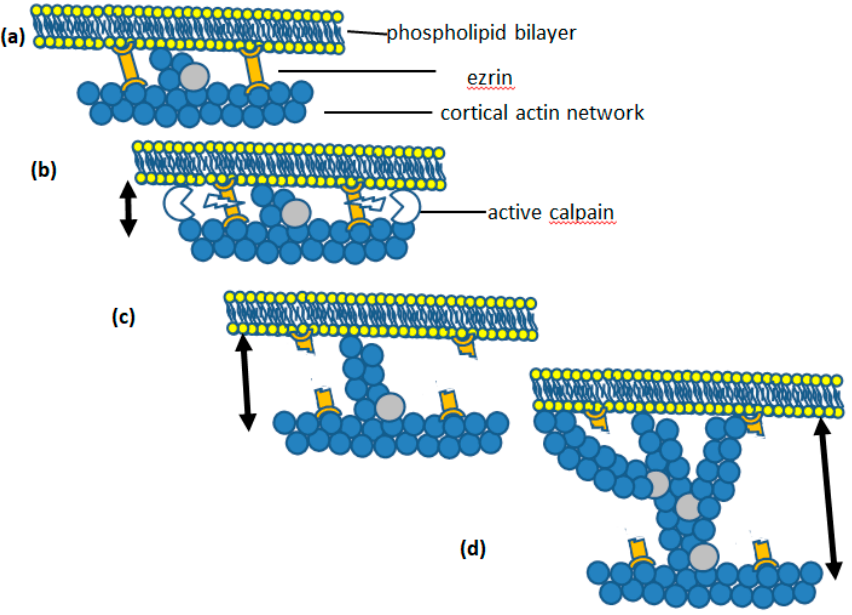
Figure 5. How ezrin cleavage initiates actin polymerisation. In ( a ), the position of the membrane in relation to the plasma membrane is stable and is also shown in Figure 2. In ( b ), the ezrin linkage is broken by the action of activated μ -calpain, which results in ( c ) the establishment of the Brownian ratchet and the growth of actin polymers ‘pushing out’ the plasma membrane. In ( d ), the actin polymer is sufficiently long enough for branch points to be added actin polymerisation continues to push out the plasma membrane. The arrows at the side of a, b, c and d show the distance from the plasma membrane to the cortical actin network increasing.